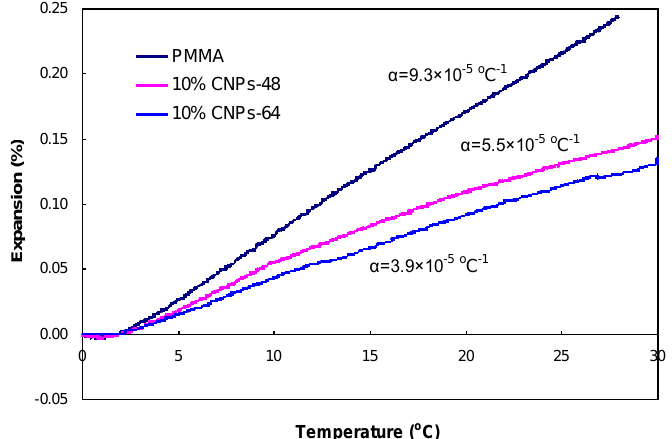
Figure 6. Comparison of thermal expansion between pure PMMA and CNP/PMMA